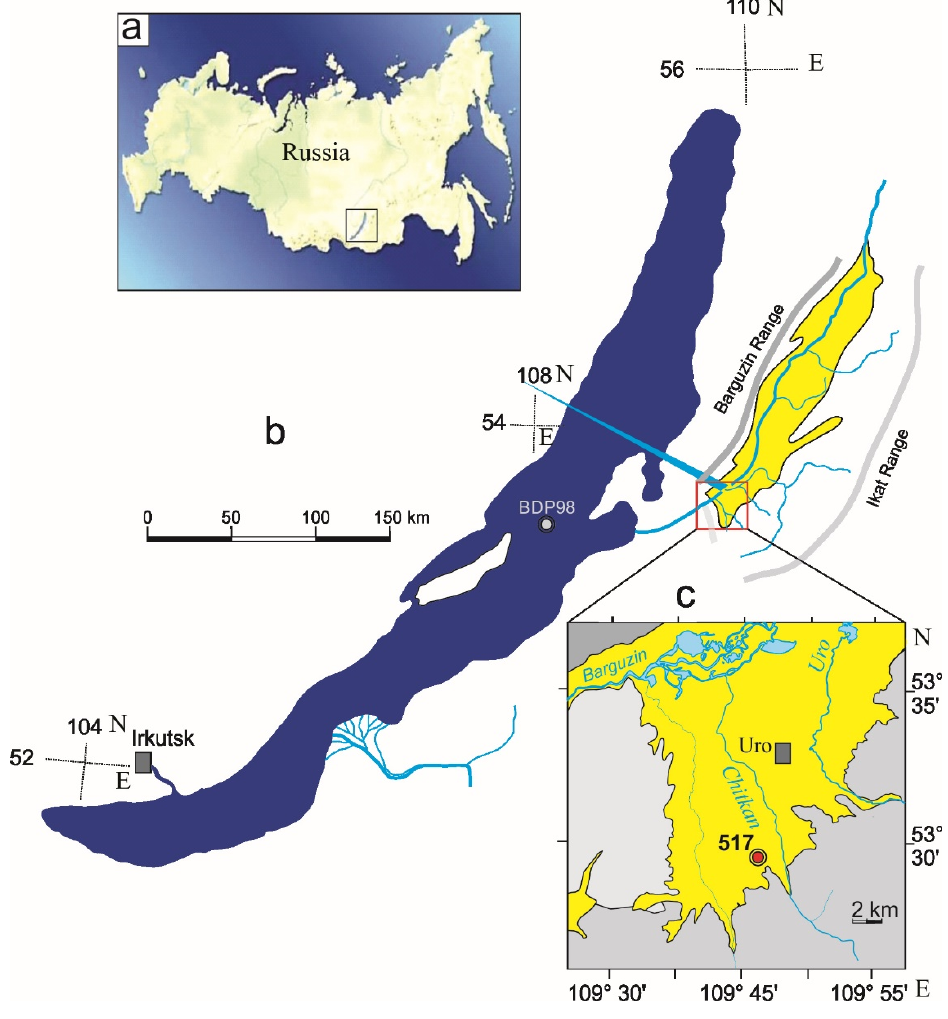
Figure 1. The location of the Lake Baikal ( a ), Barguzin Valley in the Baikal rift zone ( b ) and the location of core 517 (Uro area) ( c ).